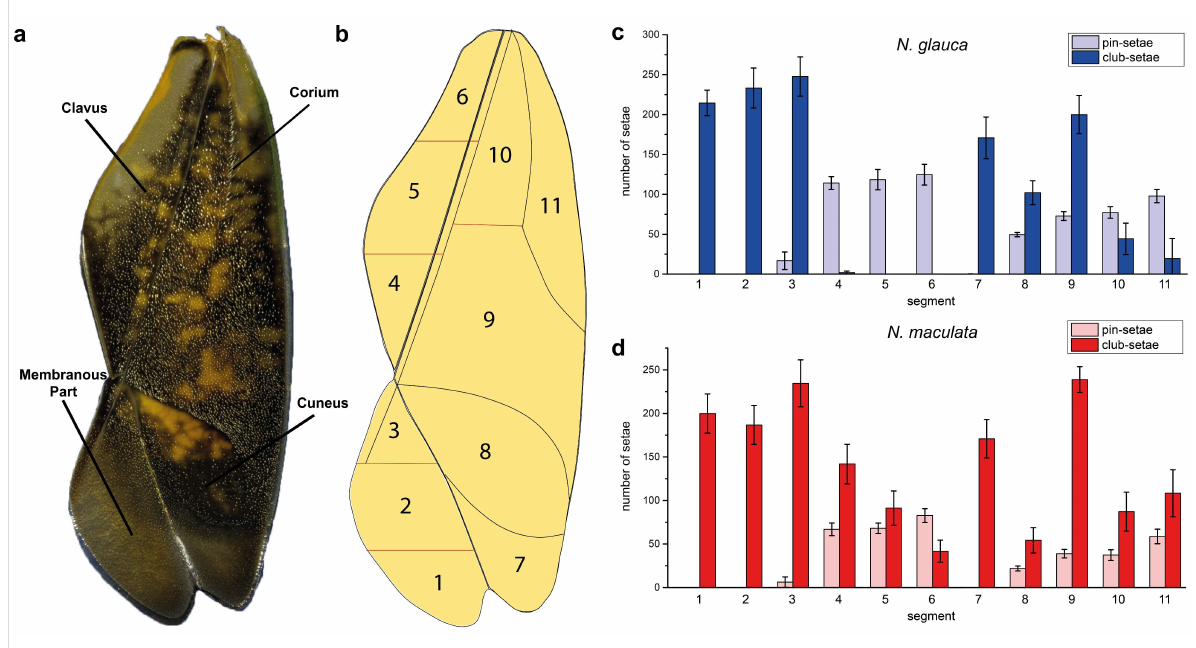
Figure 2: a) Left hemelytron of the backswimmer N. glauca . Four sections, defined by Wachmann [17], are shown. b) Scheme of the left hemelytron subdivided in 11 sections, according to Wachmann [17], and to variations in the hair density. c) Number of setae on the hemelytra of N. glauca and distribution of pins and clubs within the 11 sections shown in (b). d) Number of setae on the hemelytra of N. maculata and distribution of pins and clubs within the 11 sections shown in